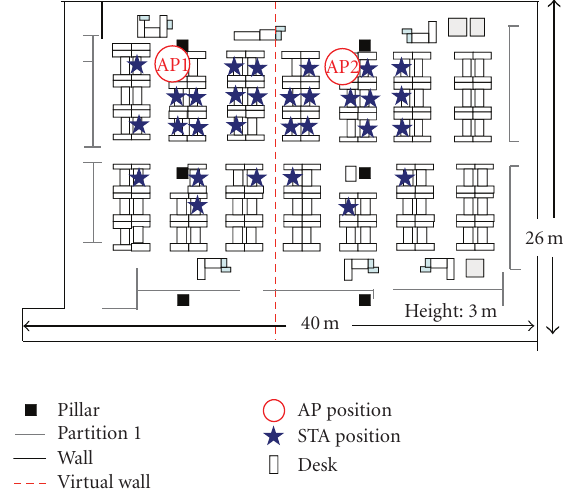
Figure 2: Experimental environment.